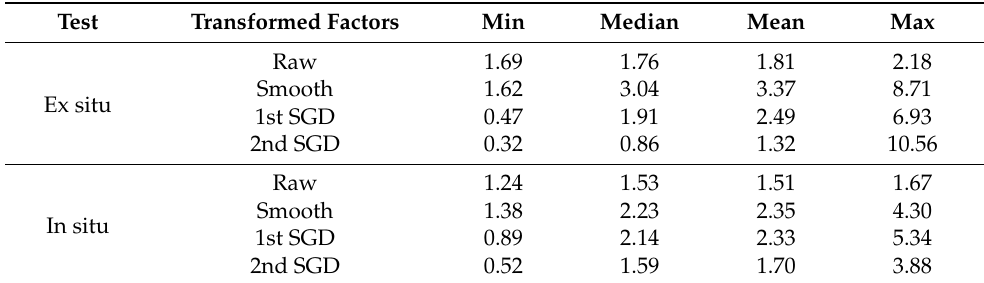
Table 2. Ratio of spread over error (RSE) comparison.